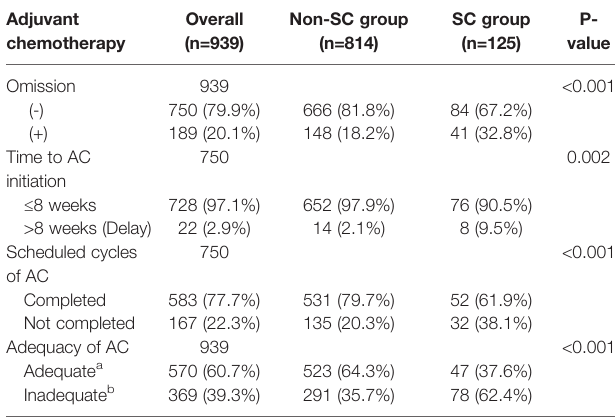
TABLE 2 | Relationship between postoperative complications and adjuvant